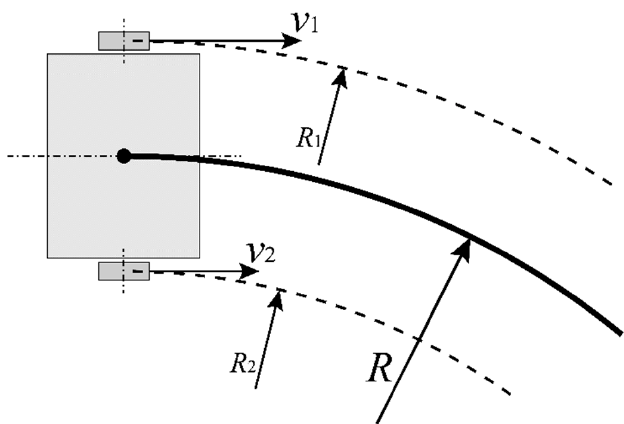
Figure 6. The arc-shaped trajectory caused by the rotation center lateral offset. Suppose that the trajectory radius of the left wheel is R 1 , and the trajectory radius of the right wheel is R 2 . The linear velocity ratio between two wheels is